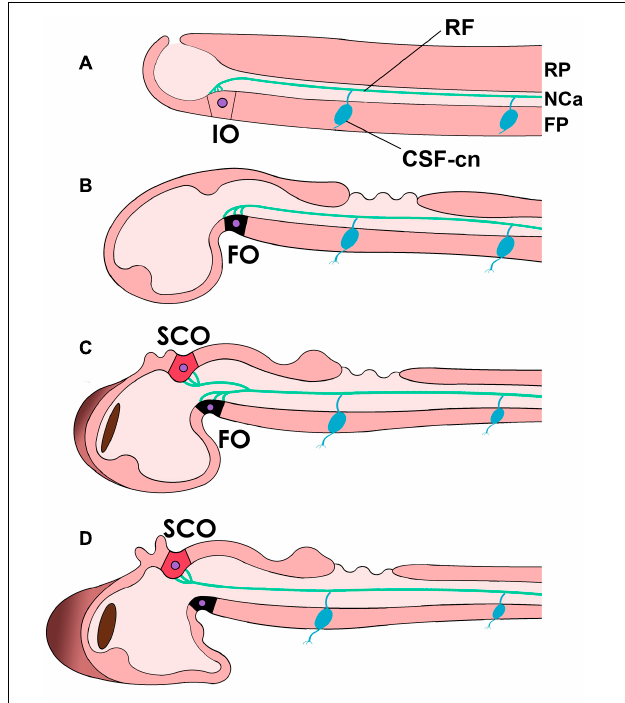
FIGURE 3 | Reissner’s fiber (RF, green) in different chordates and during development. (A) In the neural tube of cephalochordates RF is secreted by the infundibular organ of the floor plate (FP) (IO) and floats in the CSF-filled neural or central canal (NCa). (B–D) Reissner’s fiber in teleost fish [ (B) , early embryonic; (C) , middle stage; (D) , advanced]. Note that in teleosts, the flexural organ (FO, possibly homologous to the IO in cephalochordates) is replaced by the subcommissural organ (SCO) in the roof plate (RP) as the secreting organ of RF. Note also the CSF-contacting neurons (CSF-cn) with an axon (inferior process) and a dendrite or cilium that enters the CSF and contacts